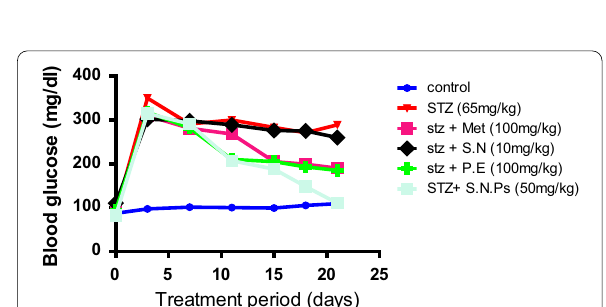
Fig. 4 Time course changes in fasting blood glucose (FBG)